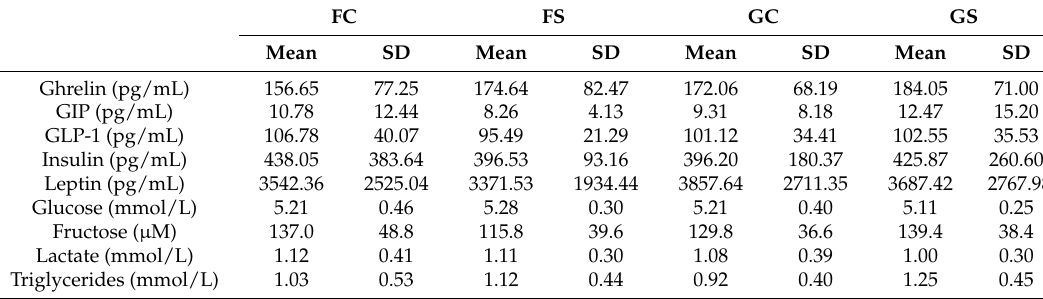
Table 2. Baseline concentrations for blood serum